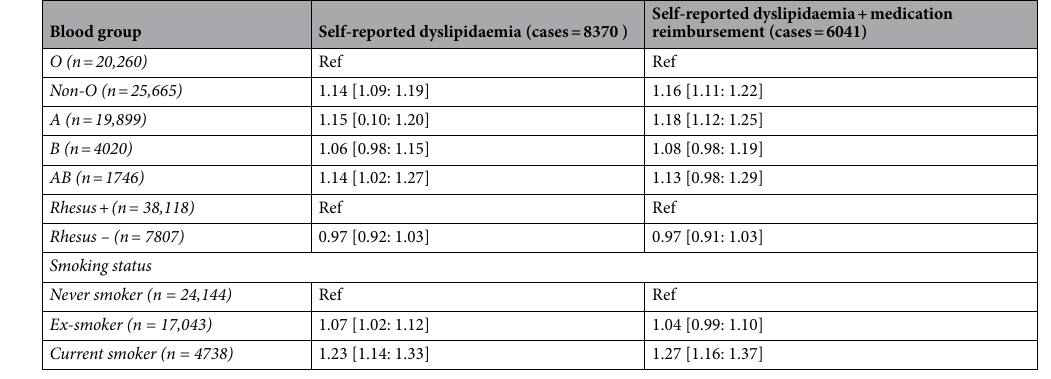
Table 2. Risk of incident dyslipidaemia depending on blood ABO group, hazard ratios (HR) estimated from Cox proportional hazards models. Adjusted for body mass index, physical activity, education level,